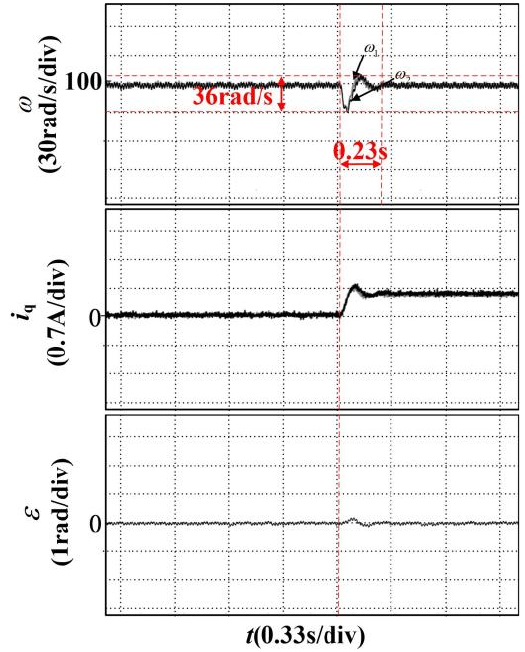
Figure 18. Motor responses when the load are added simultaneously.